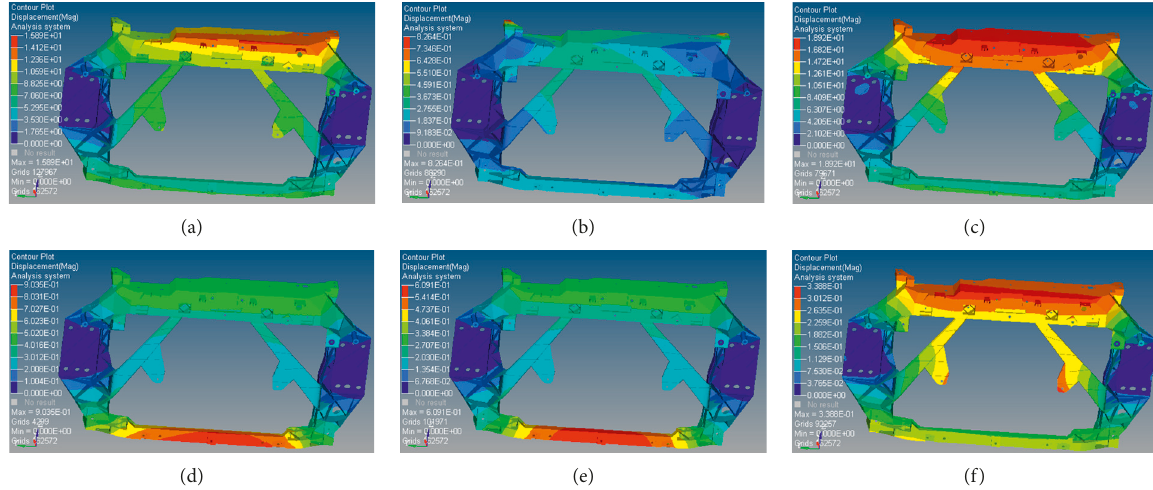
Figure 20: Front-end framework displacement cloud. (a) Latch limit tension displacement cloud chart; (b) cloud diagram of cushion impact displacement; (c) cloud image of pedestrian impact displacement; (d) displacement cloud diagram of condenser support strength; (e) displacement cloud diagram of radiator support strength; and (f) cloud map of oil cooler installation strength displacement.